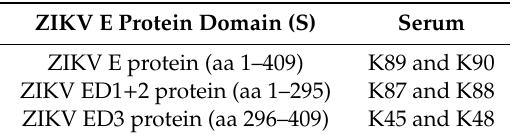
Table 1: Table 1. ZIKV E domain selection for sera